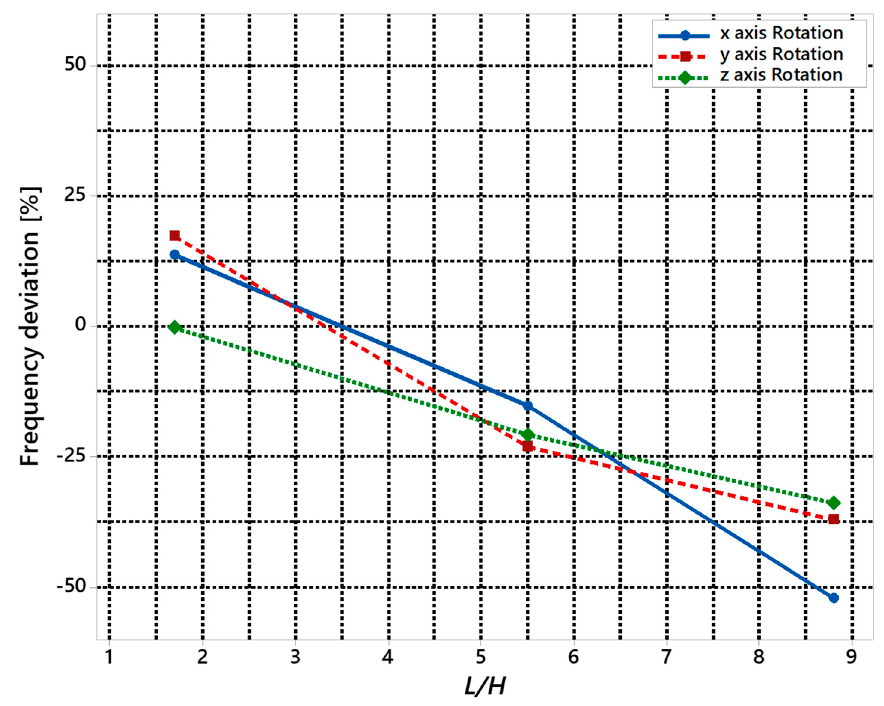
Figure 13. Rotational frequency deviation at different values of L/H .